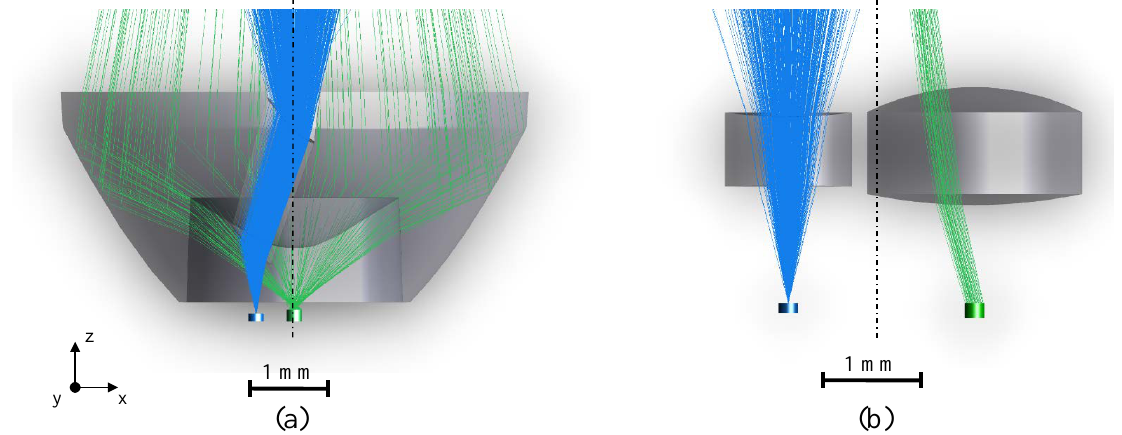
Figure 6. Render of the cross-section through the optical system with TX rays (blue) and RX rays (green). Both devices are placed on the rotation axis (black dotted line) with no misalignment. Only RX rays that hit the detector are shown. ( a ) Hybrid TX-RX lens (H TX-RX). ( b ) Fully separated TX and RX (S TX-RX) in worst-case orientation, i.e., TX lens facing TX lens and RX lens facing RX lens.